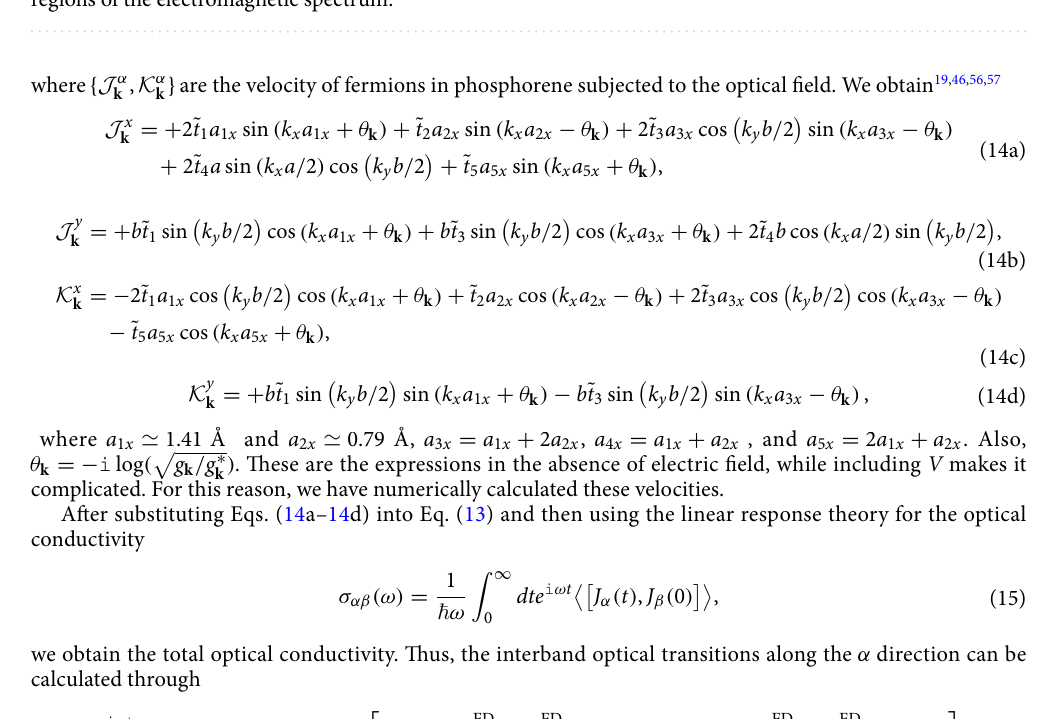
Figure 4. Left side, general interband optical transitions and excitations between different bonding and antibonding electronic orbitals in phosphorene. Right side, electron energy loss spectrum of “pristine” monolayer BP along both AC and ZZ directions inside the infrared (IR), visible (VIS), and ultraviolet (UV) regions of the electromagnetic